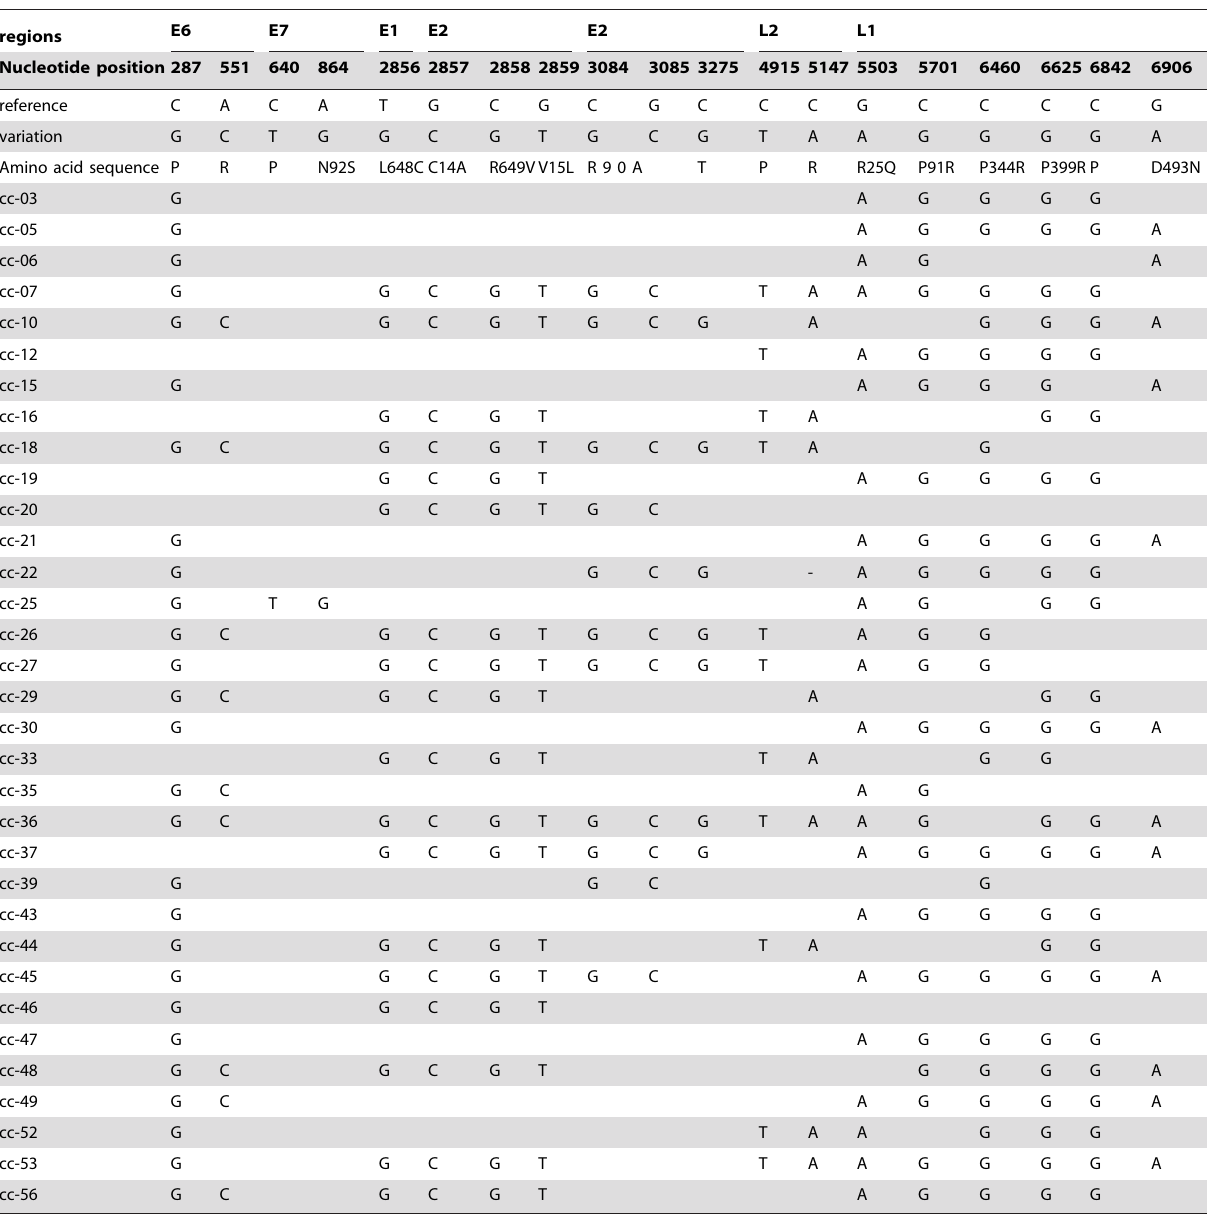
Sequence variations of HPV-18 E1, E2, E6, E7, L1 and L2 were based on the HPV-18 reference sequence (NC_001357). The identification codes of the specimens are indicated along the far left column. The number and the letter represent the nucleotide variation at that position. Blanks indicate no variation. In the ‘reference’ row, the letters represent the nucleotides in the reference sequence. In the ‘amino acid sequence’ row, the number and the letter represent the AA change at that position.